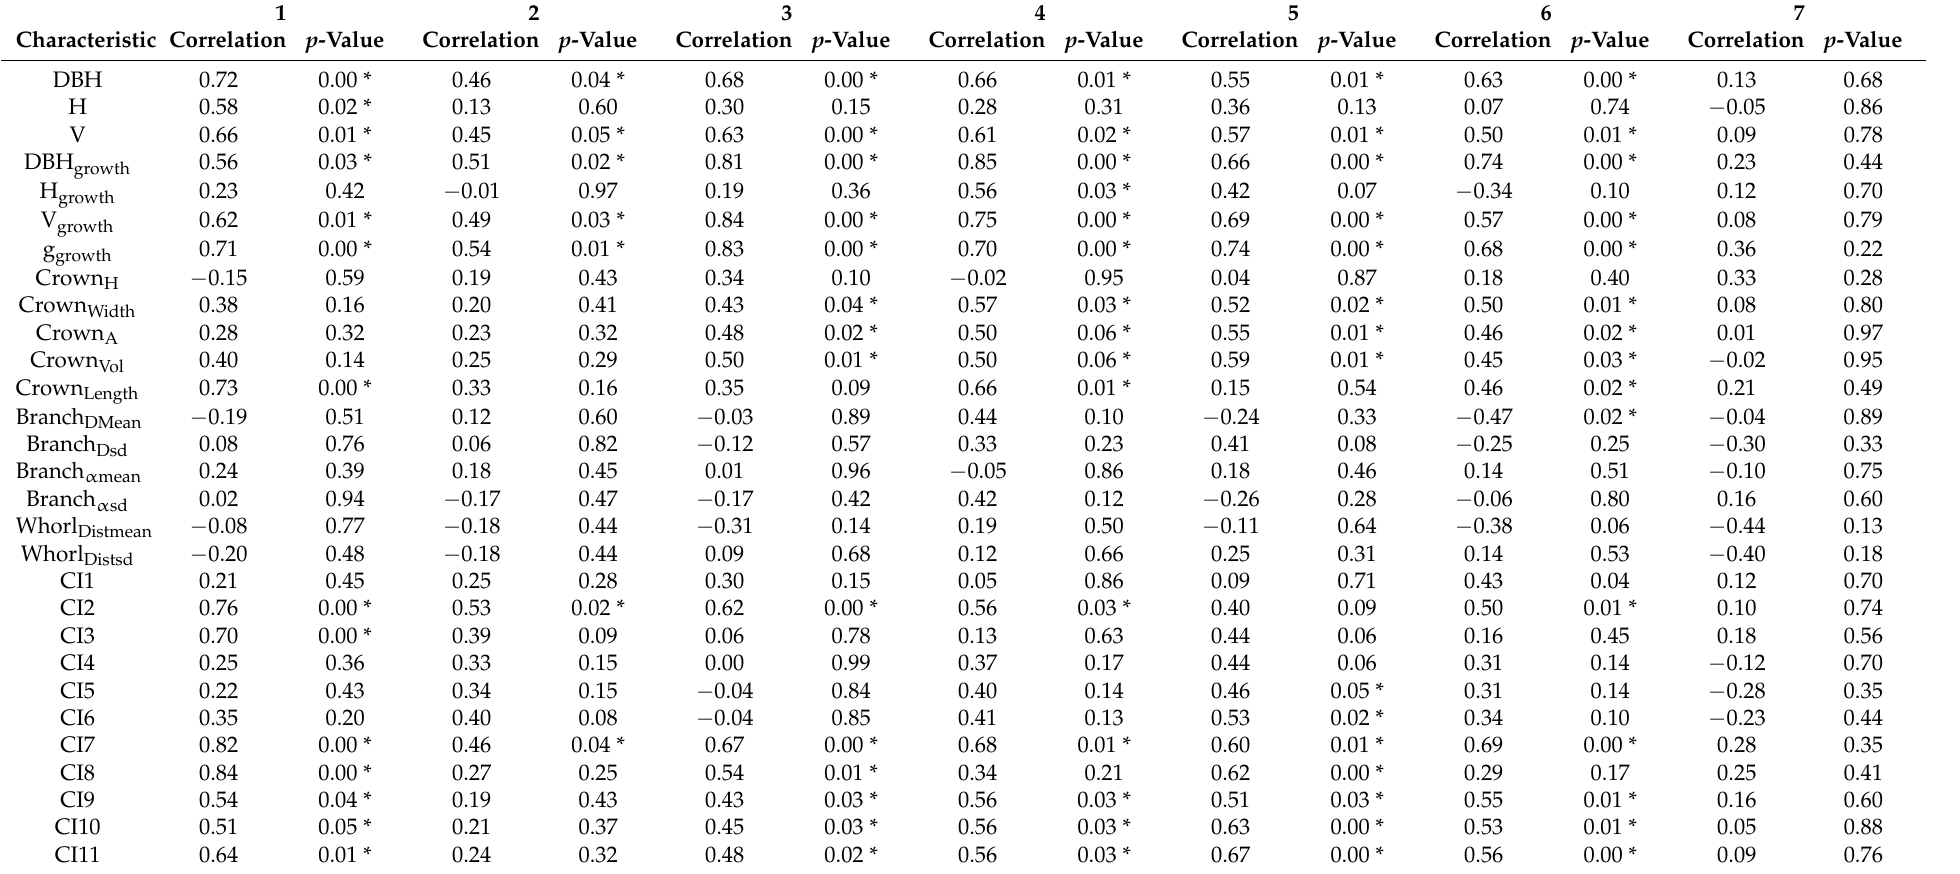
Table A2. Pearson’s correlation coefficients between mean ring width (RW mean ) and tree structural characteristics (refer to Table 2 for descriptions) within different thinning treatments (i.e., moderate below (1), moderate above (2), moderate systematic (3), intensive below (4), intensive above (5), intensive systematic (6), no treatment (7). Moderate refers to thinning guidelines applied in Finland [43] whereas intensive results in 50% lower remaining basal area (m 2 /ha) compared to moderate thinning. Control refers to plots without thinning treatments since the establishment. * Indicates a statistical significance (i.e., p -value ≤